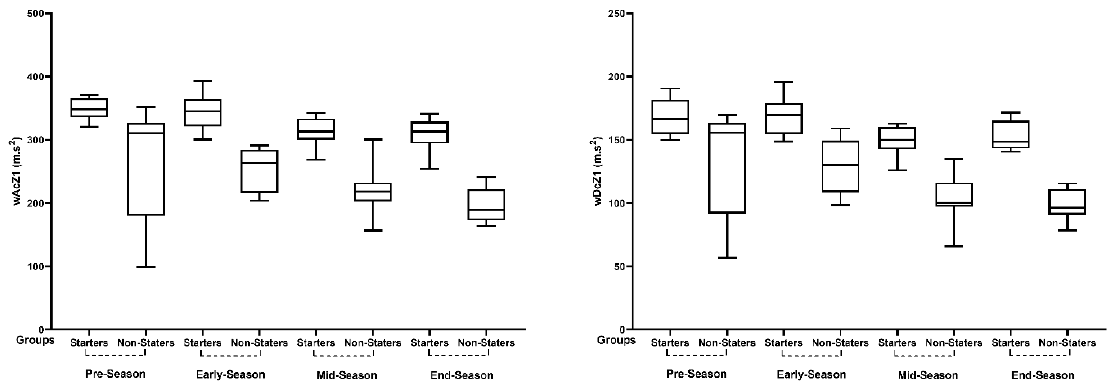
Figure 2. Pairwise comparisons between season periods in wAcZ1, the average weekly time spent on the acceleration threshold of zone 1 (<2 m · s 2 ) and wDcZ1, the average weekly time spent on the deceleration threshold of zone 1 (> − 2 m · s 2 ); m · s − 2 , meters per second squared.